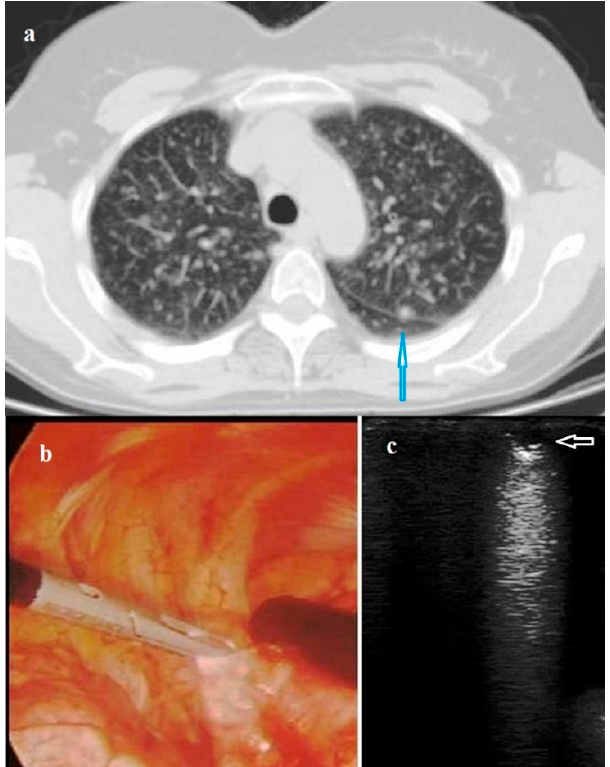
Figure 1. ( a ) Axial Chest Computed Tomography (CT) scan showing a not subpleural micronodule (blue arrow) in the left lung (maximum diameter 7.00 mm) not visualized during surgery nor identified by manual palpation. ( b ) Photograph showing the intracavitary laparoscope probe (8–12 MHz) placed on the left lung during Video-Assisted Thoracoscopic Surgery (VATS). ( c ) Intraoperative lung ultrasound during VATS (VAT-US) showing the pulmonary nodule (white arrow) with a hypoechoic US pattern, regular rounded shape and well-defined margins. The final Histological diagnosis was pulmonary Langerhans cell histiocytosis X.